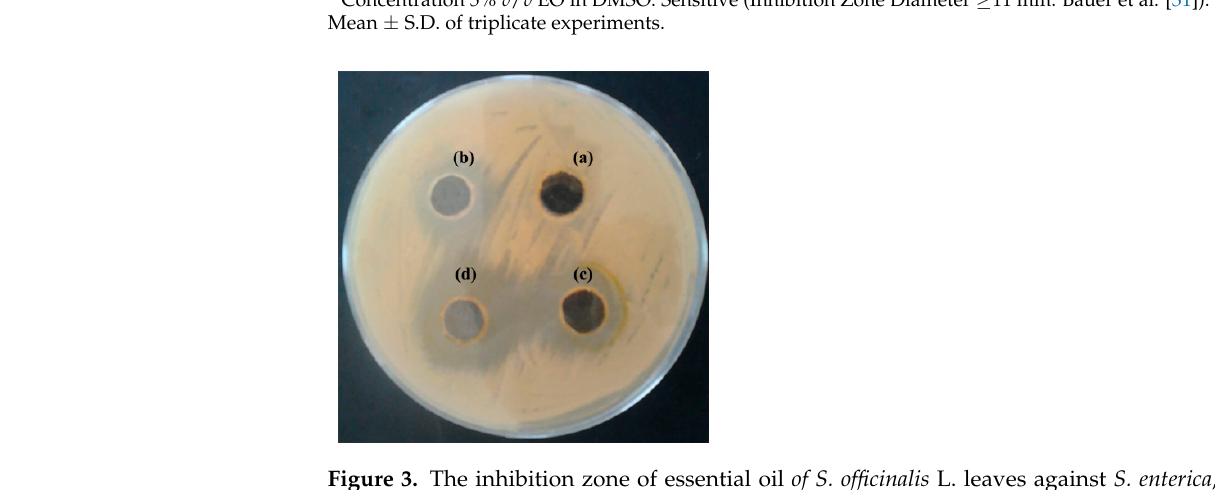
Results are Mean ± S.D. of triplicate experiments.